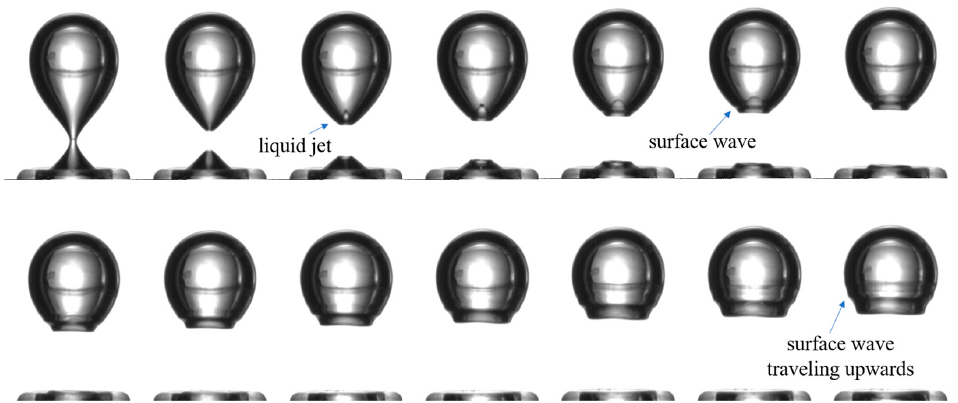
Figure 2. A bubble breakaway event in RO water and subsequent surface wave; images were continuously taken at 6000 frames per second.